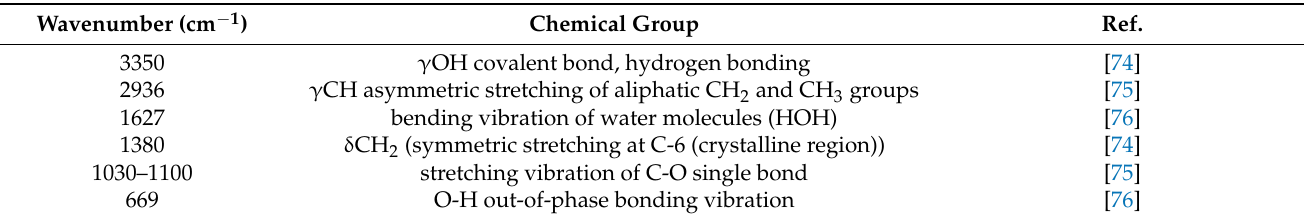
Table 5. Values of beetroot BNC FT-IR spectra wavenumber attributed to the chemical activities. Chemical